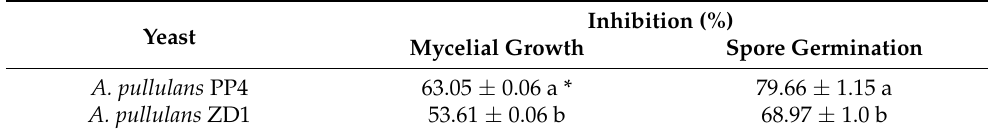
Table 1. In vitro effects of tested yeast on A. flavus